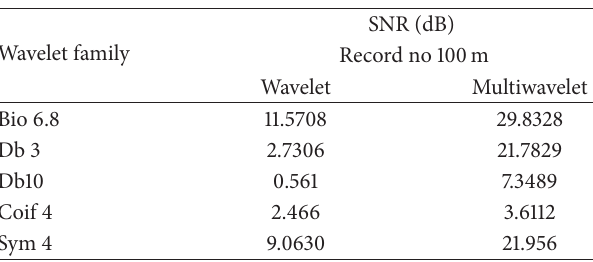
Table 1: Performance comparison of wavelet and multiwavelet for record 100 m.